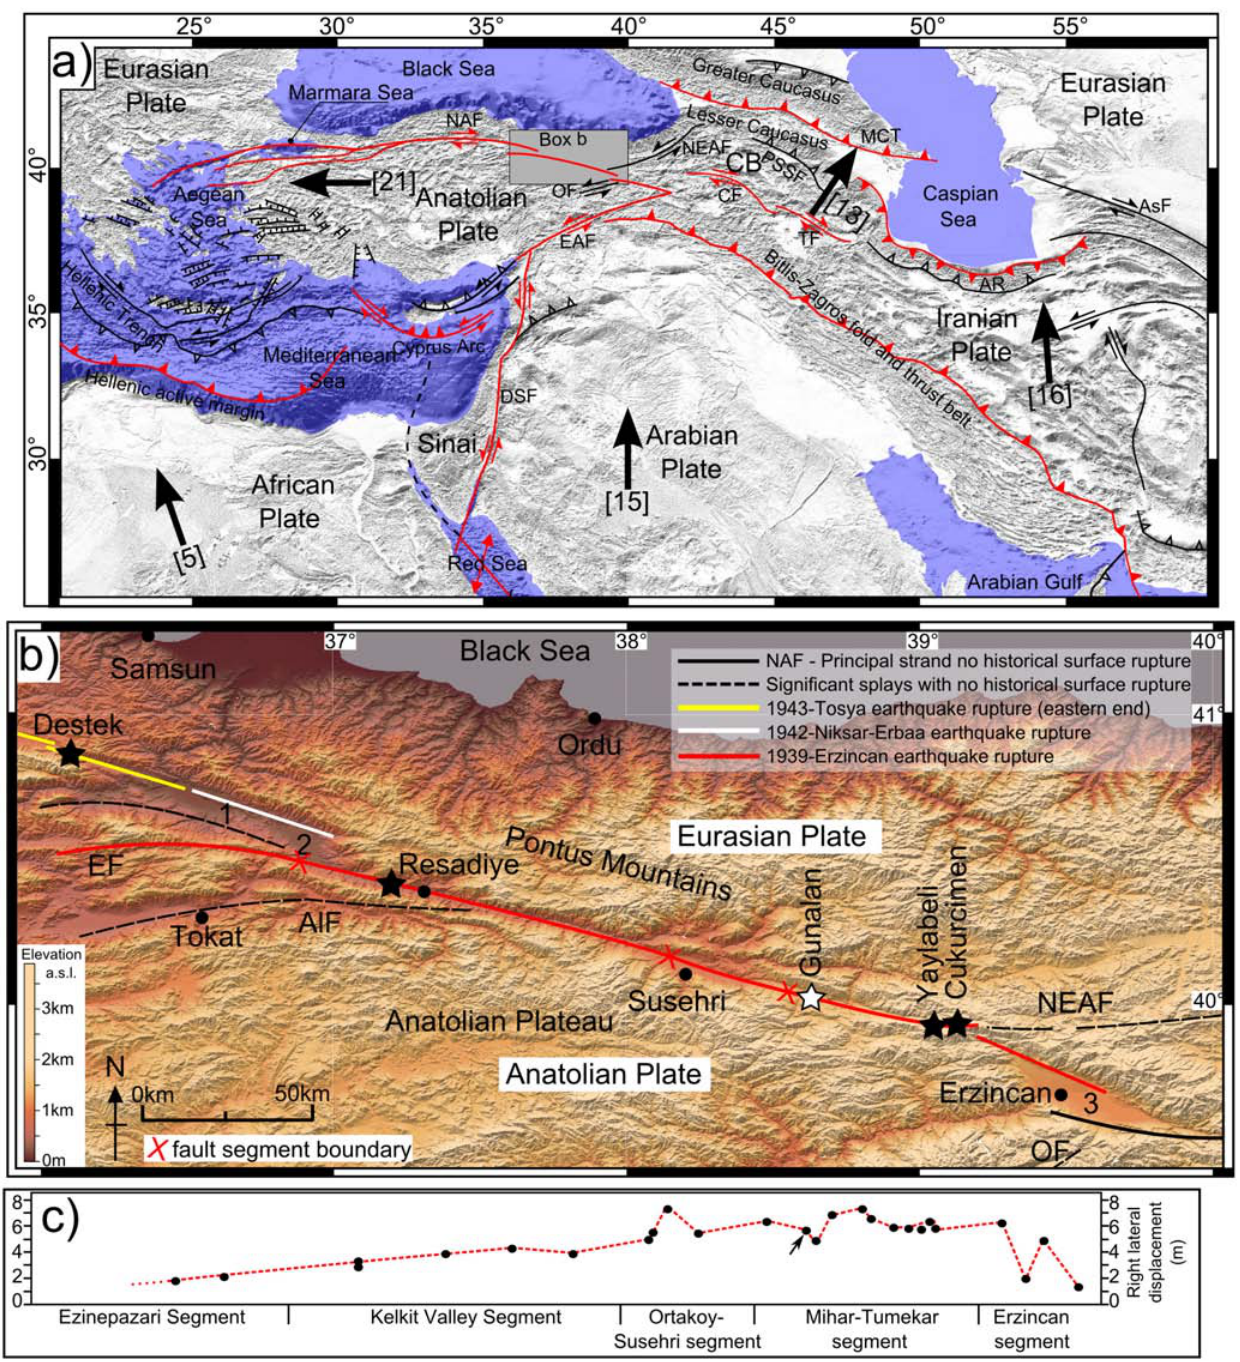
Figure 1. (a) Map of the Anatolian plate region. Heavy black arrows show the direction of plate motion based on GPS studies (relative to a fixed Eurasia), with the velocity in mm/yr shown in brackets [Reilinger et al. 2006]. Red lines depict present plate boundary faults, and black lines are important faults. DSF, Dead Sea Fault; NAF, North Anatolian Fault; EAF, East Anatolian Fault; NEAF, Northeast Anatolian Fault; MCT, main Caucasus thrust; AR, Alborz Range; CB, Caucasus Block; CF, Chalderan Fault; TF, Tabriz Fault; AsF, Ashgabat Fault; PSSF, Pembak-Sevan-Sunik Fault; and OF, Ovacik Fault. (modified from Fraser et al. [2010a]). (b) Map of 20th century earthquake ruptures near Günalan (location of map shown by rectangle labelled ‘box b’ in Figure 1a). Paleoseismic trench locations are shown with stars (this study white, other studies black), and filled circles show selected major settlements. Significant pull-apart basins are numbered: 1) Tasova–Erbaa pull-apart basin, 2) Niksar pull-apart basin and 3) Erzincan pull-apart basin. Significant fault splays are labeled: EF, Ezinepazari Fault; AlF, Almus Fault; and OF, Ovacik Fault. (c) Fault segments and right-lateral displacements associated with the 1939 Erzincan earthquake (modified from Barka [1996], see references therein). The irrigation canal offset by 5.6 m, ca. 2.5 km west of Günalan (Figure 2a) [Ko ç yi ğ it 1990, p. 165] is included in the Barka [1996] plot and indicated with an